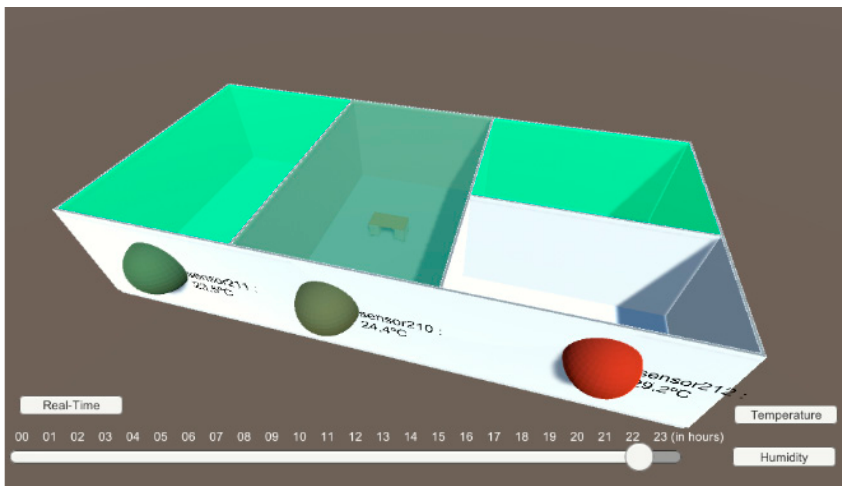
Figure 2. Unity visualization app, with the building information model (BIM) and real-time sensor data.